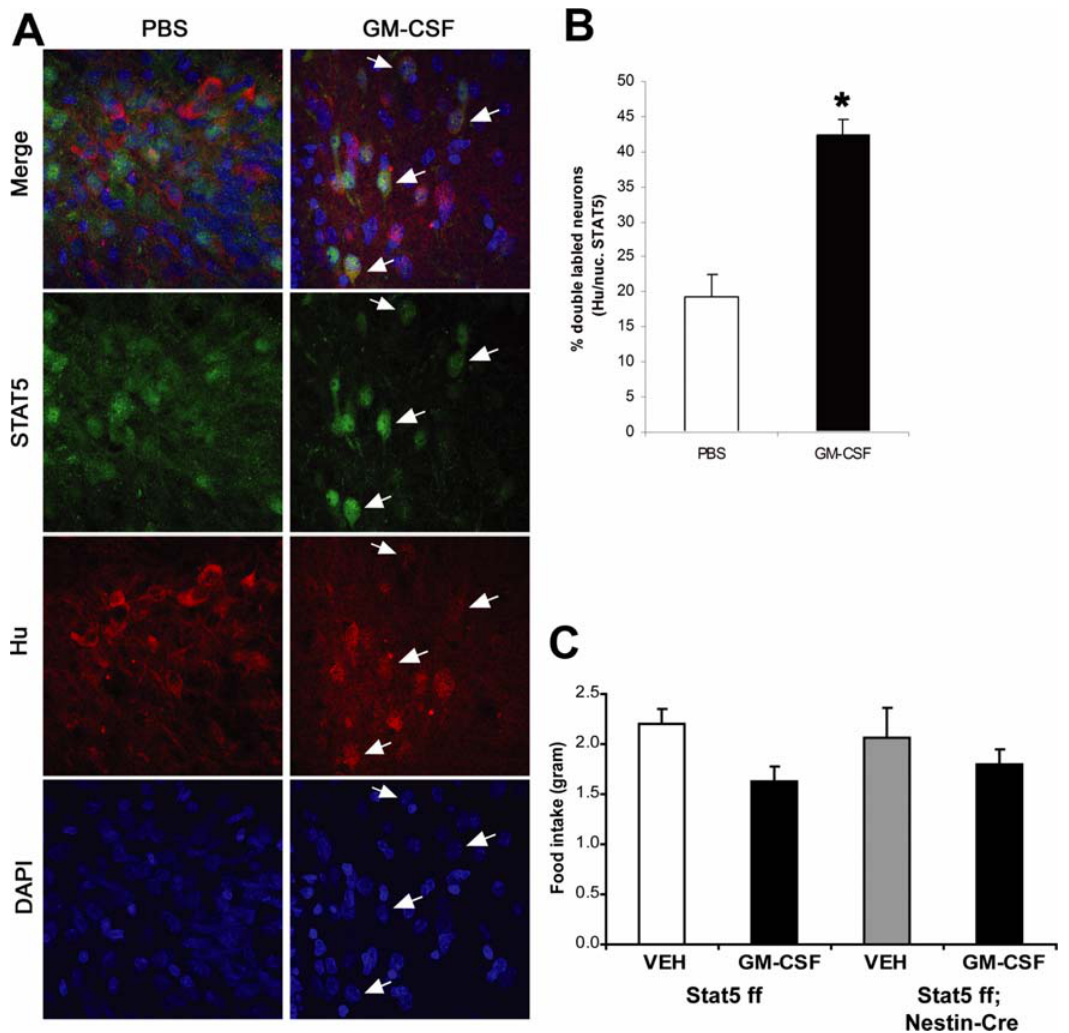
Figure 9. GM-CSF induces STAT5 activity in the hypothalamus and Stat5 fl/fl;Nestin-Cre male mice do not respond to GM-CSF-induced reduction of food intake. (A) Rats were treated with vehicle (left panels) or GM-CSF (right panels) i3vt for 60 minutes and the presence of nuclear STAT5 was analyzed by counting STAT5-positive (green) nuclei of Hu-positive (red) neurons following immunofluorescent analysis with a STAT5 antibodies. Dapi staining to reveal nuclei is shown in blue. Representative images from the LHA are shown, along with percent of neurons with nuclear STAT5 localization. (B) graph of double labeled cells; n=4; *p , 0.01 vs vehicle by students t test. (C) Recombinant mouse GM-CSF was injected into the third ventricular region of 8 week-old Stat5 fl/fl; Nestin-Cre mice and Stat5 fl/fl control littermates and food intake was measured after 4 hrs (N=16 for Stat5 ff vehicle (body weight 29.8 6 0.9) and Stat5 ff GM-CSF ((body weight 29.4 6 0.9), n=6–7 for Stat5 ff; Nestin-Cre (body weight 29.7 6 1.7) vehicle and Stat5 ff; Nestin-Cre GM-CSF(body weight 29.7 6 1.8)) . Two-way ANOVA tests followed by the ‘Holm-Sidak test’ revealed significant effect of GM-CSF on food intake (F(1,40)=4.6, P=0.039 showed a significant reduction of food intake with control mice and no significant reduction was observed with mutant mice. The p value for the drug effect was 0.039. Using ‘All pairwise multiple comparison procedures’ the p value for drug effect within wild type was 0.008. No significant effect was observed in the mutant group (p 0.435).